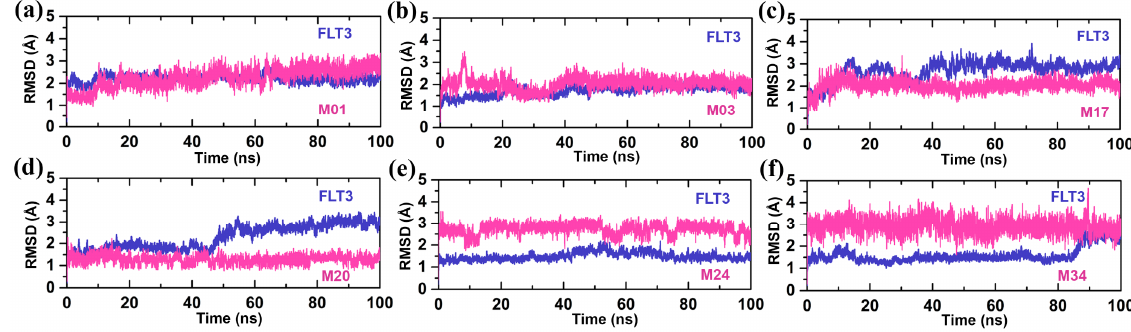
Figure 3. ( a ) FLT3-M01, ( b ) FLT3-M03, ( c ) FLT3-M17, ( d ) FLT3-M20, ( e ) FLT3-M24, and ( f ) FLT3-M34 are the RMSD graphs of protein–ligand complexes. The protein and ligand RMSDs are shown in slate and pink colors, respectively.